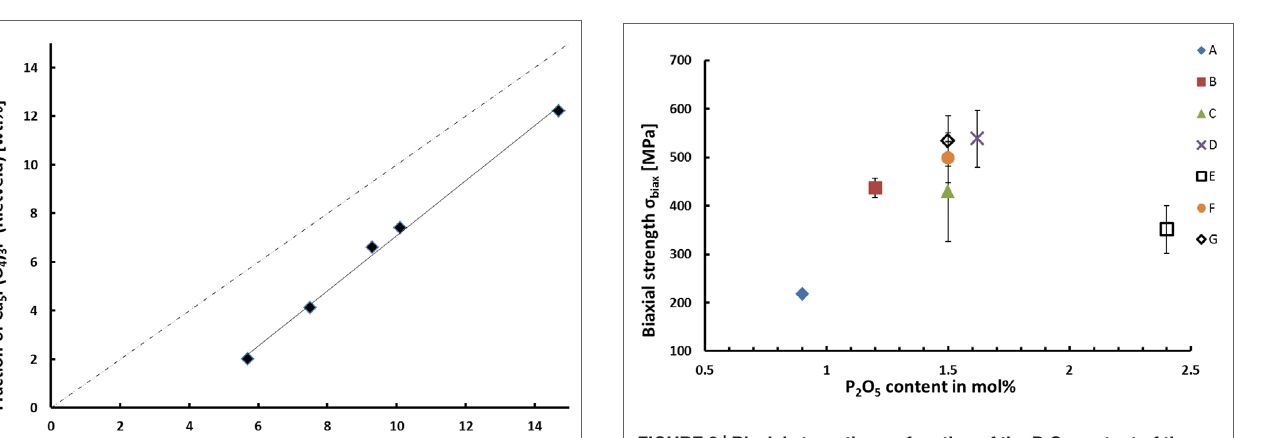
FigUre 8 | Biaxial strength as a function of the P 2 O 5 content of the glass-ceramics nucleated at 500°c for 30 min and subsequently crystallized at 800°c for 30 min